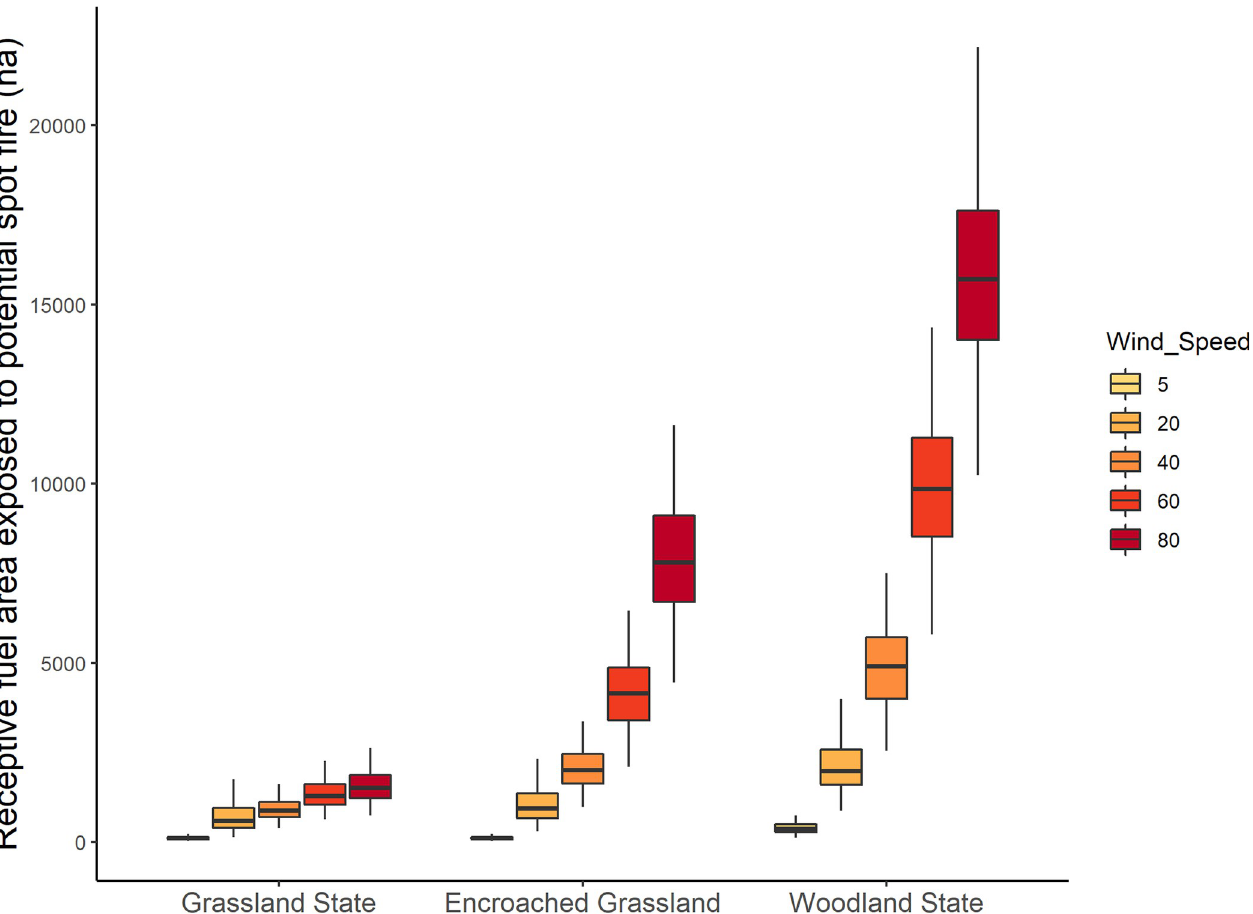
Fig 4. The change in receptive fuel area exposed to potential spot fire surrounding individual burn units in the Loess Canyons Experimental Landscape as juniper encroachment level and wind speed increase.